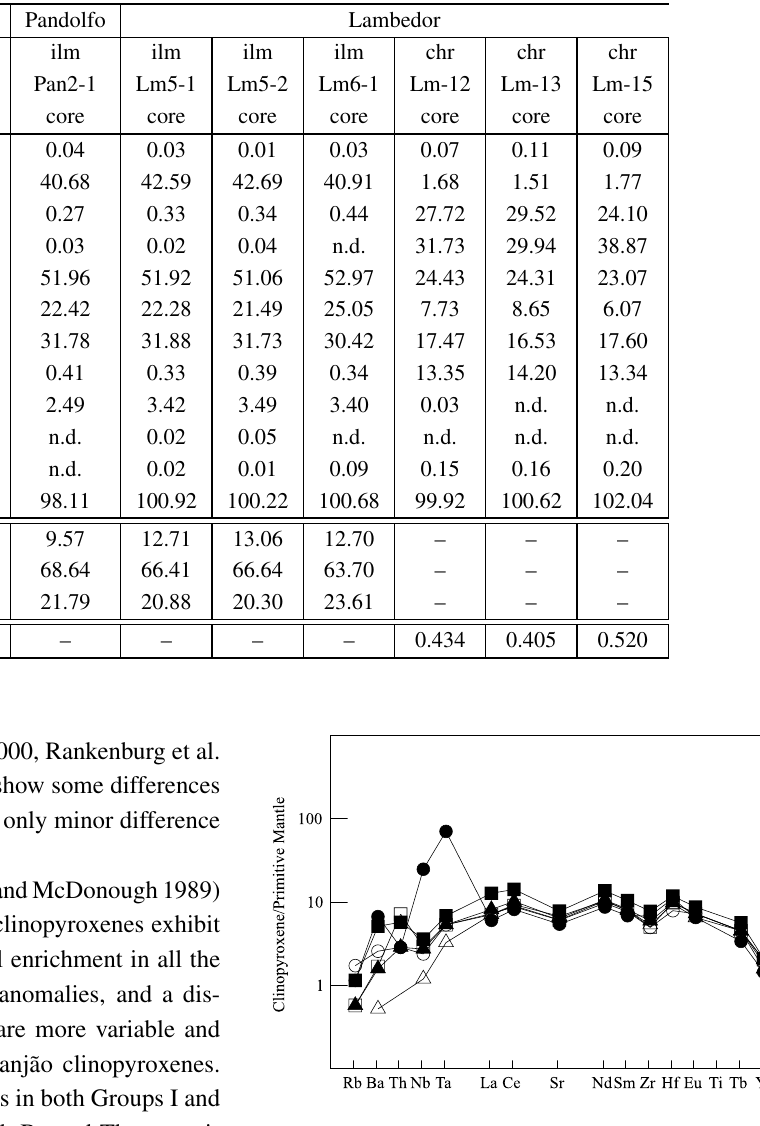
Fig. 8–Primitivemantlenormalized(SunandMcDonough1989)REE and trace element patterns of clinopyroxenes from the Janjão, Pandolfo and Lambedor diatremes. Symbols as in Fig.